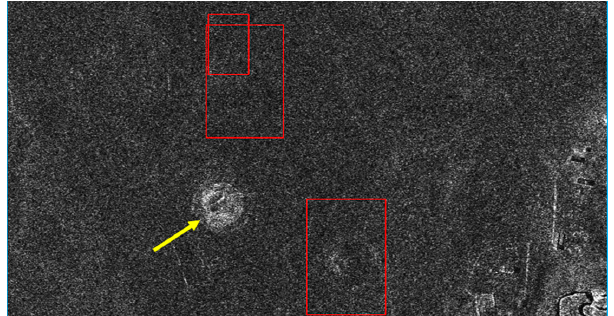
Figure 3. Cluster of Saka kurgans in the TSX ST image from 16 September 2015 (SAR image © DLR, 2015). ( Saka kurgans = red, Scythian kurgans = green, ogradkas = purple, undatable mounds = yellow, and all other objects = cyan).